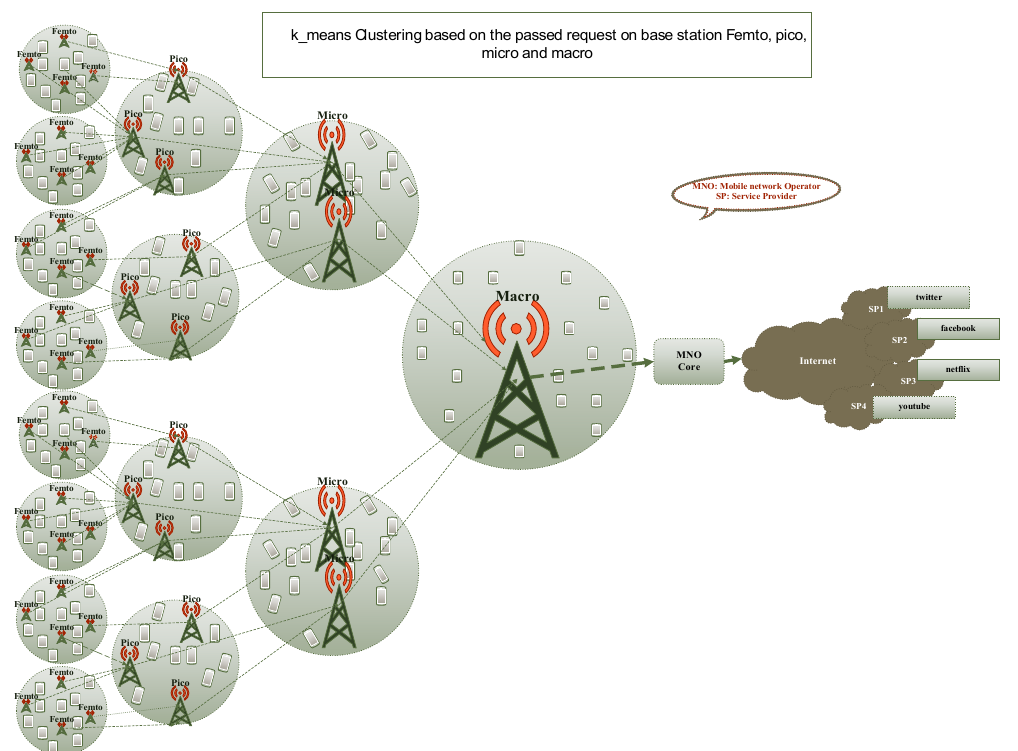
Figure 1. Cluster formation in each tier using K-mean clustering.